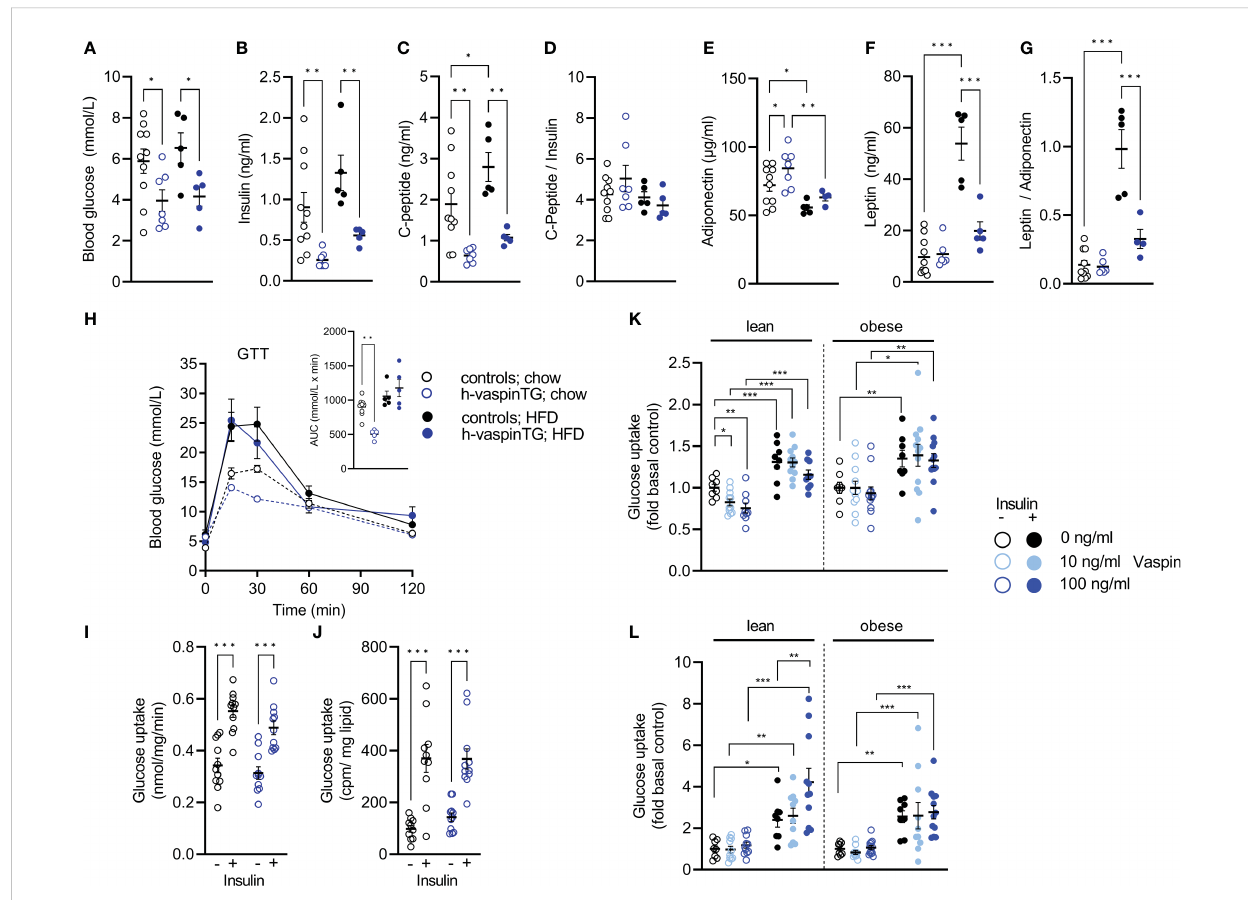
FIGURE 3 h-vaspinTG mice display healthier serum pro fi le under high fat diet (HFD). (A) Blood glucose (mmol/L), (B) insulin (ng/ml) and (C) C-peptide levels (ng/ml), as well as (D) C-peptide/insulin ratio, (E) adiponectin (µg/ml) and (F) leptin levels (ng/ml), as well as (G) adiponectin/leptin ratio of h- vaspinTG and control mice fed a chow or HFD for 23 weeks. (H) Glucose tolerance tests (GTT) and area under the curve (AUC, presented in insert) in h-vaspinTG and control mice fed a chow or HFD. (I, J) Ex vivo glucose uptake in (I) EDL muscle (mmol/mg/min) and (J) epididymal adipocytes (cpm/mg lipid) of h-vaspinTG and control mice fed a chow or HFD (n = 5-10). (K, L) Relative ex vivo glucose uptake in (K) EDL muscle and (L) epididymal adipocytes from lean and obese C57BL/6N mice, treated with either 10 ng/ml or 100 ng/ml recombinant vaspin and compared to untreated controls (n = 8-12). Data are presented as mean ± SEM. Statistical signi fi cance was calculated by one-way ANOVA followed by Fisher ’ s LSD test (*p ≤ 0.05, ** p ≤ 0.01, ***p ≤